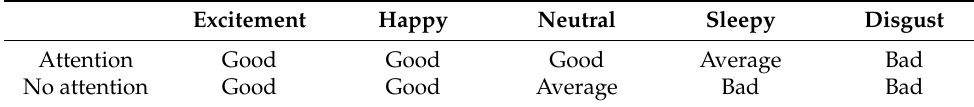
Table 4. Behavior matrix based on emotion class and attention